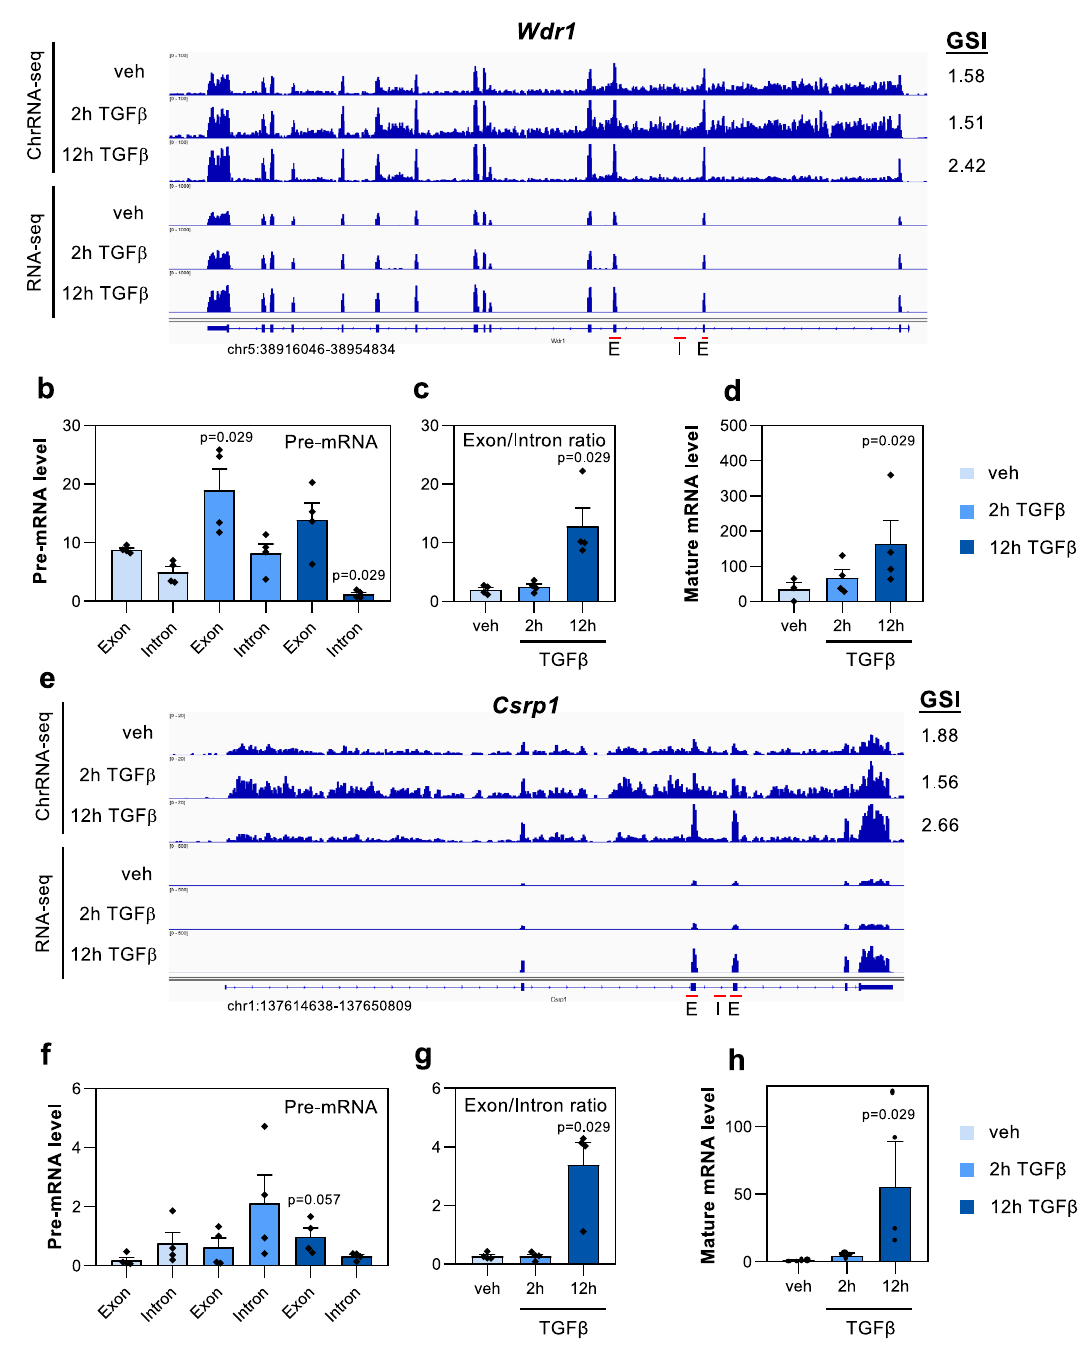
Fig. 6 Effects on gene expression of GSI changes after 12 h of TGF β addition. a , e ChrRNA-seq and RNA-seq IGV snapshot of Wdr1 ( a ) and Csrp1 ( e ) genes in vehicle or at 2 or 12 h after TGF β treatment. b , f Exon and intron levels of Wdr1 ( b ) and Csrp1 ( f ) transcripts in nascent chromatin-associated RNA isolated at the three conditions tested: vehicle or at 2 h or 12 h after TGF β . Levels were determined by RT-qPCR, using exon – exon or exon – intron amplicons (oligonucleotides indicated as red arrows). c , g Exon/intron ratios for Wdr1 or Csrp1 transcripts using data shown in b , f , respectively. d , h Mature mRNA levels of Wdr1 and Csrp1 genes at the three conditions tested: vehicle (control) or at 2 h or 12 h after TGF β addition determined by RT-qPCR using RNA from the cytoplasmic fraction and exon – exon oligonucleotides (indicated as red arrows). b – d , f – h Values represent the mean ± SEM of four ( n = 4) independent biological replicates. Unpaired two-tailed Mann – Whitney p -values of the indicated comparison are shown. Sample size ( n ) of all set of data are provided in Supplementary Data